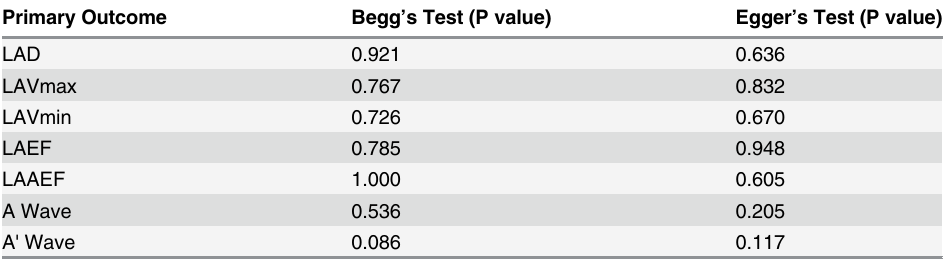
Table 3. Assessment of publication bias with Stata 12.0 for each primary